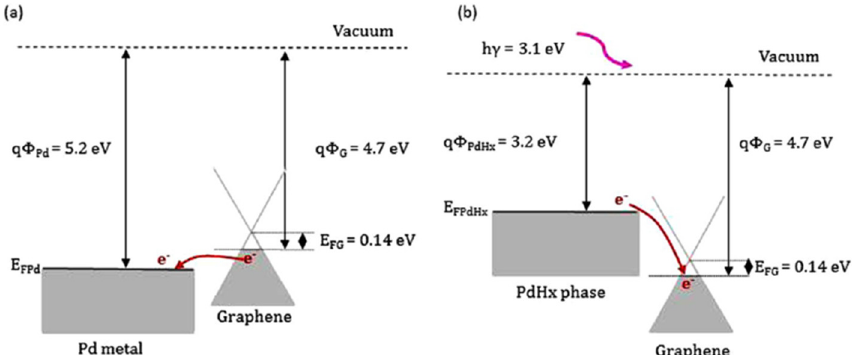
Figure 37. Energy band diagrams ( a ) for Pd decorated graphene and ( b ) for PdHx and graphene [162]. Copyright (2019), with permission from Nature Publisher Group. Copyright (2019), with permission from Nature Publisher